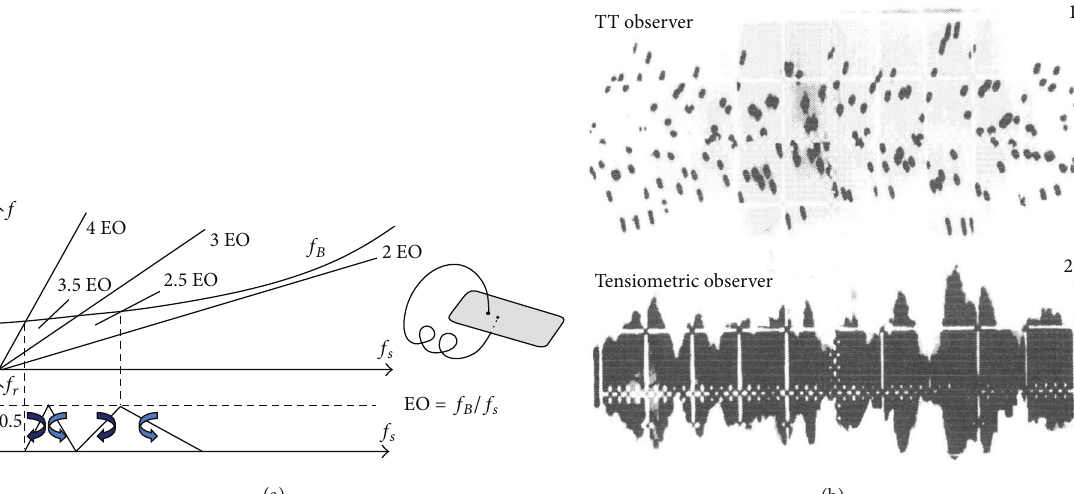
Figure 21: Relation between vibration of the blade top (the TT observer, 𝑓 =4kHz). Three first modal frequencies of the blade: 350Hz, 1380 Hz, and 1890 Hz, max. rotational frequency strain gauge observer, 𝑓 sampling = 260 Hz of the rotor 𝑓 rotor , max